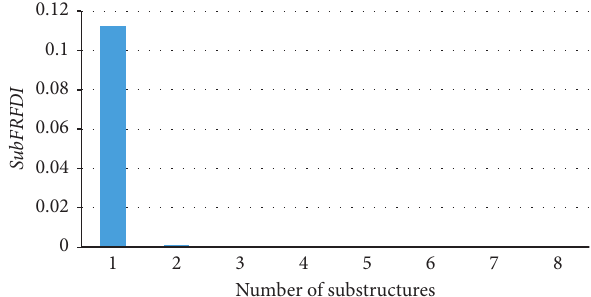
Figure 32: SubFRFDI values of DIC-measured data for case Dam100_1F.